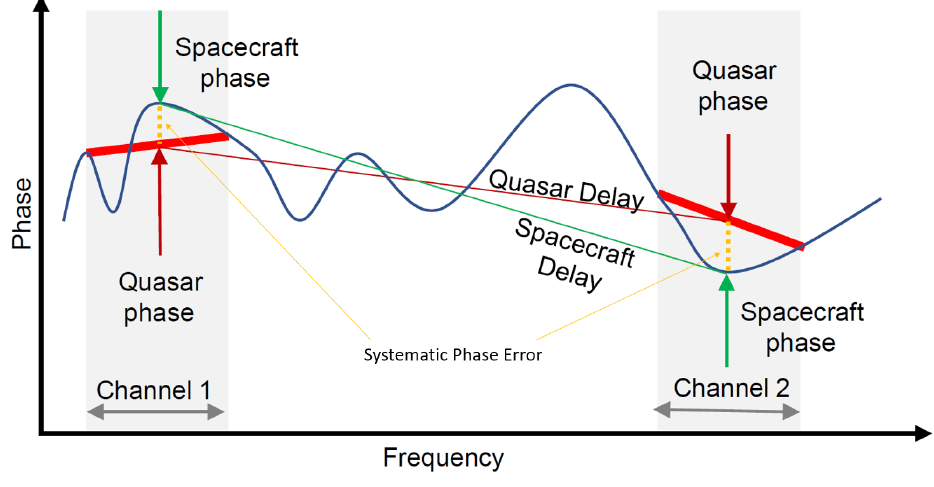
Figure 2. Systematic error in ∆ DOR